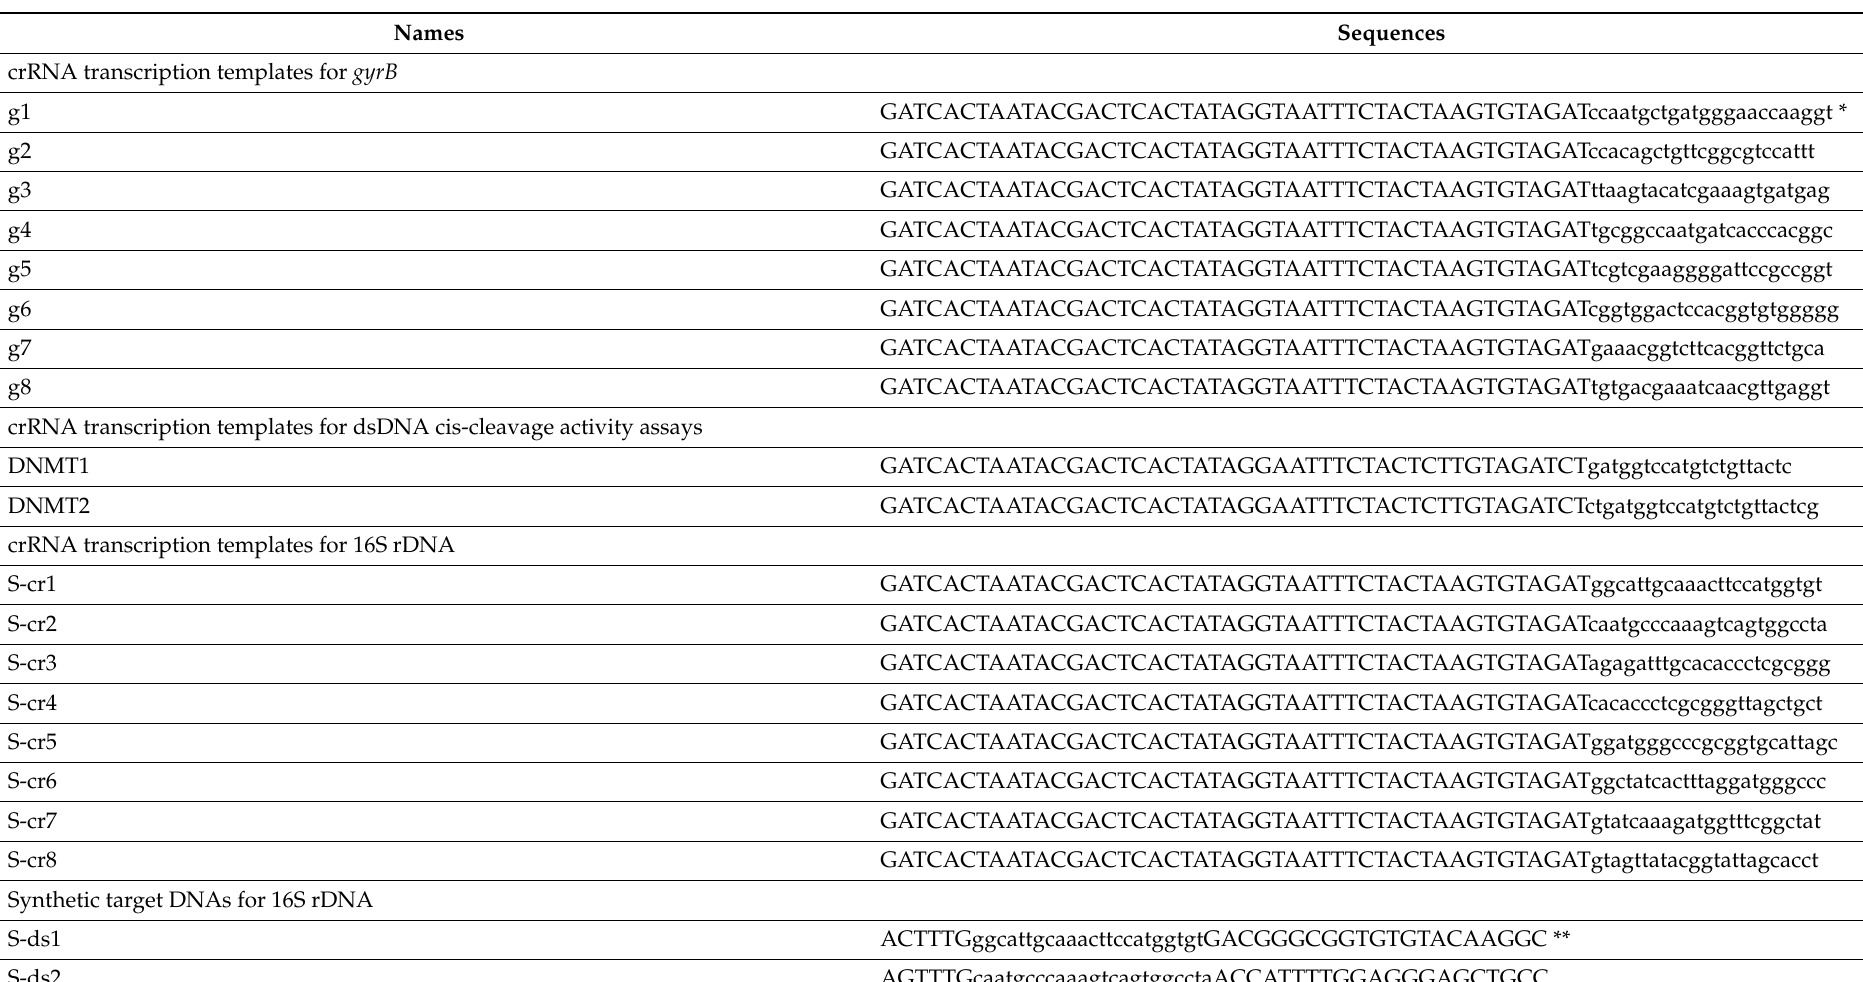
Table 1. DNA sequences used in this